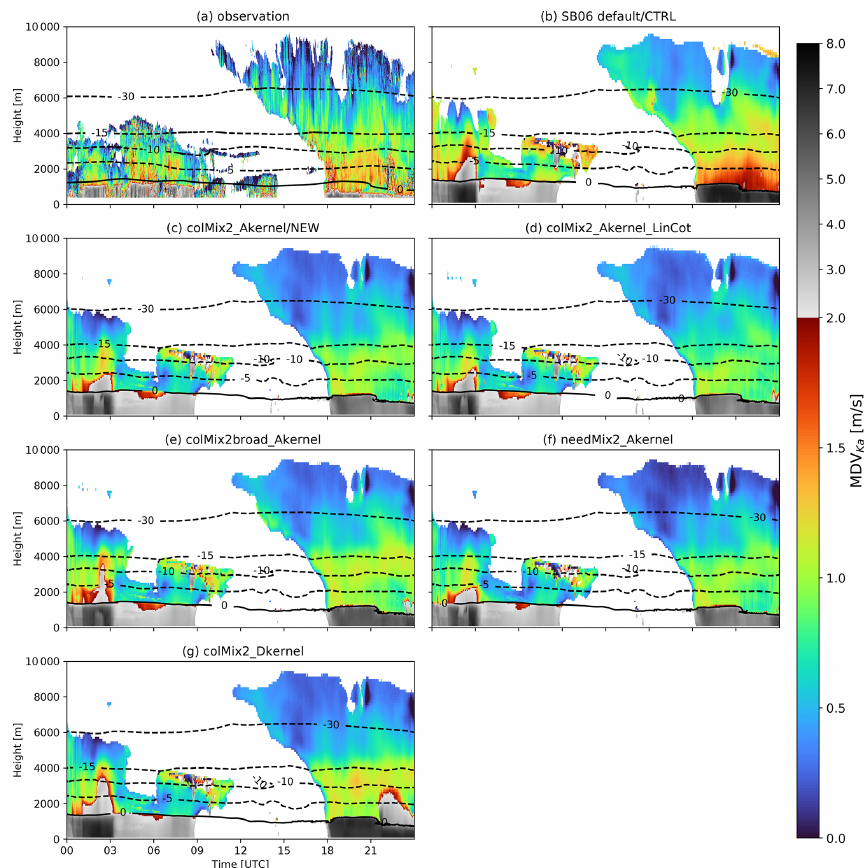
Figure 10. Same as Fig. 8 but displaying MDV Ka , which is strongly linked to v t